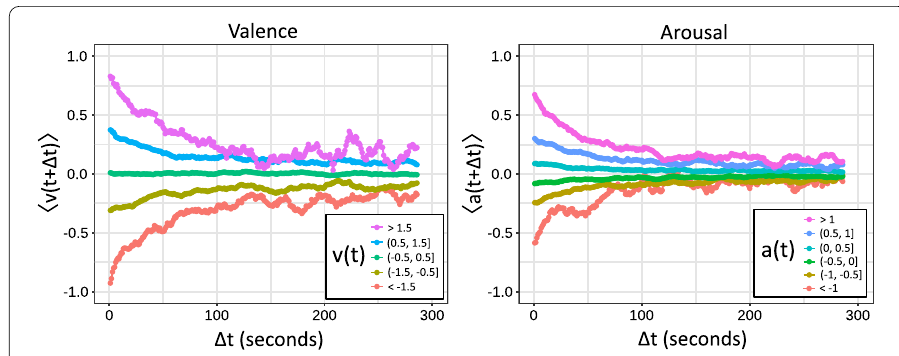
Figure 4 Valence and arousal relaxation towards an affective baseline. Mean values of valence and arousal (after correcting for individual baselines) in status updates following a preceding one generated (cid:4) t seconds before. Lines are aggregated by the emotions expressed in the first message to illustrate relaxation trends. Means are calculated over a rolling window of size 15 (seconds) over all status updates of all users and plot up to a maximum (cid:4) t of 300 seconds. Relaxation happens homogeneously above and below the baseline for both valence and